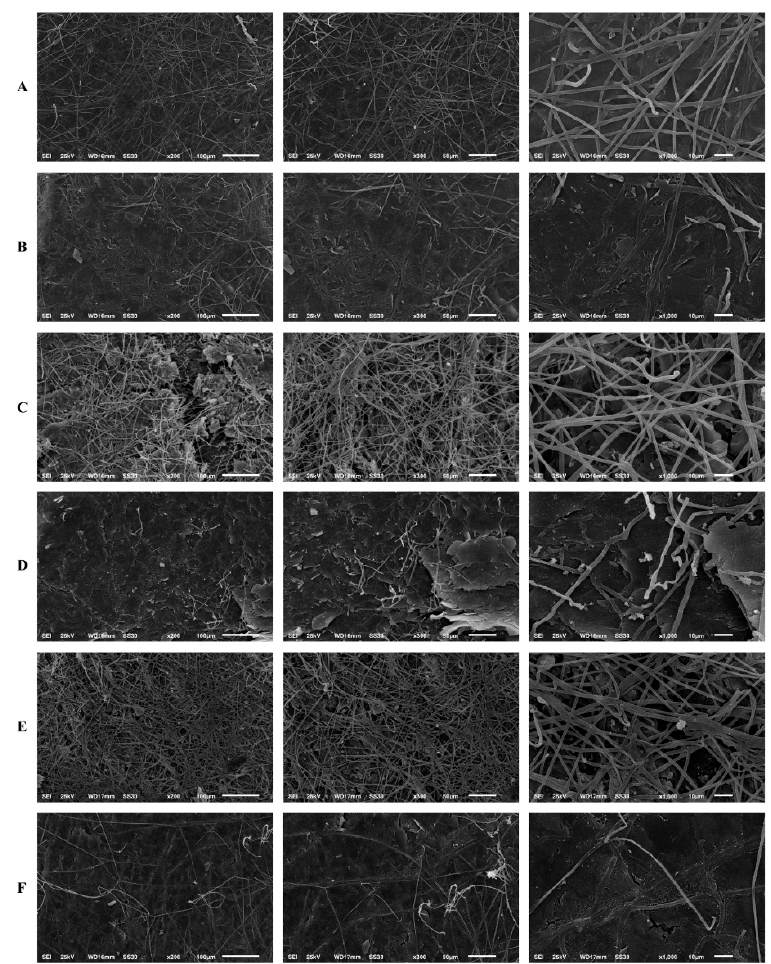
Figure 6. Scanning electron microscopy of the T. rubrum biofilm on a human nail. T. rubrum strain growth on nail fragments in the absence of drugs ( A ). Treatment with SRT 50 mg/L ( B ), SRT 12.5 mg/L ( C ), CASP 62.50 mg/L ( D ), CASP 3.90 mg/L ( E ) and SRT 12.5 mg/L + CASP 3.90 mg/L ( F ), 20 days of after biofilm